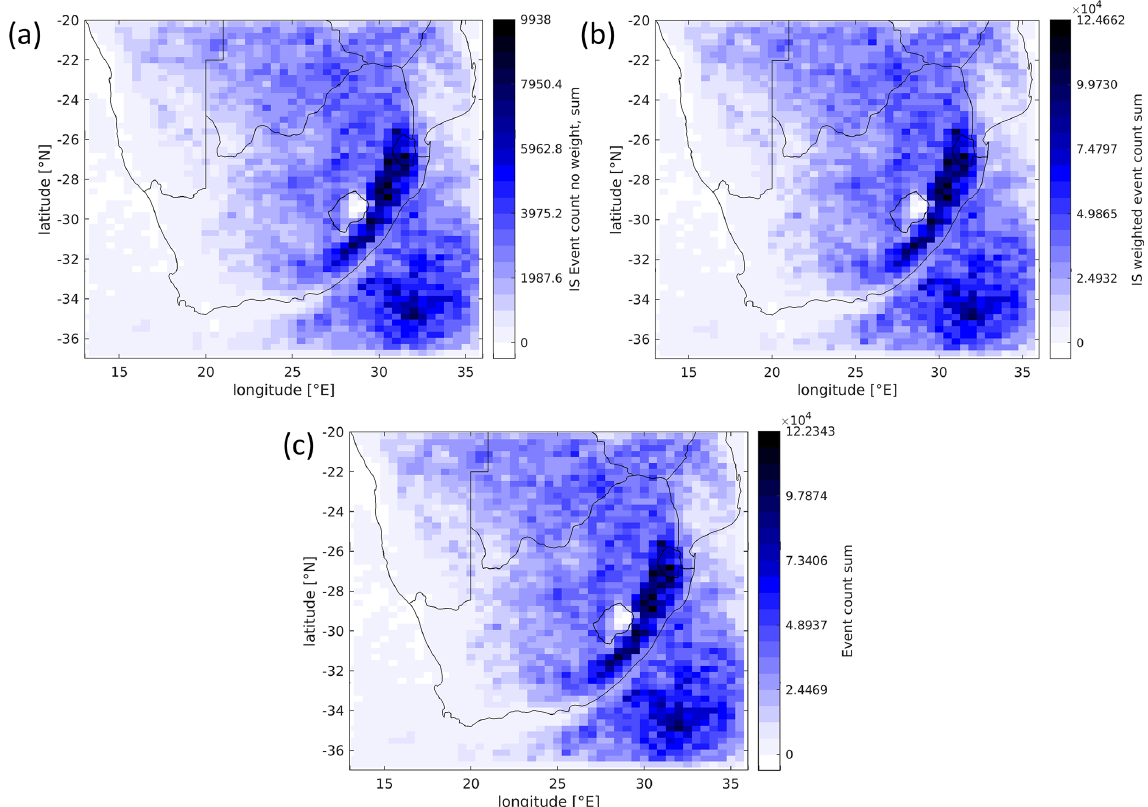
Figure 17. (a) Number of events retained by the importance sampling; (b) as (a) but weighed by frequency; (c) event frequency before importance